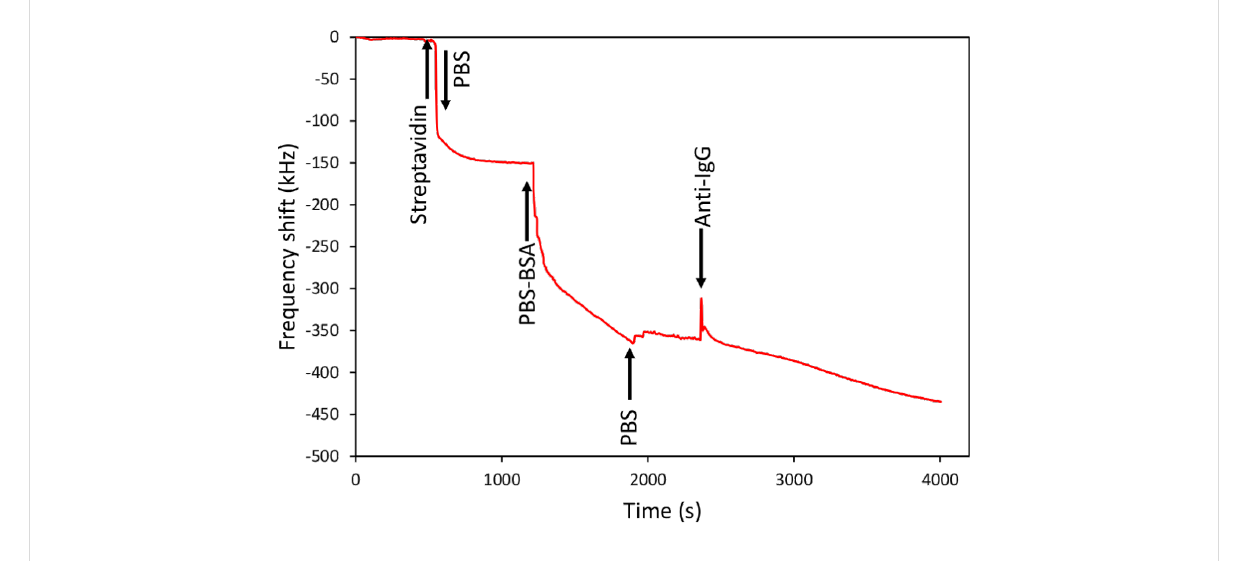
Figure 7: Resonant frequency evolution of a resonator during the non-covalent functionalization with anti-IgG antibody. The arrows indicate the moments at what the liquids are changed.